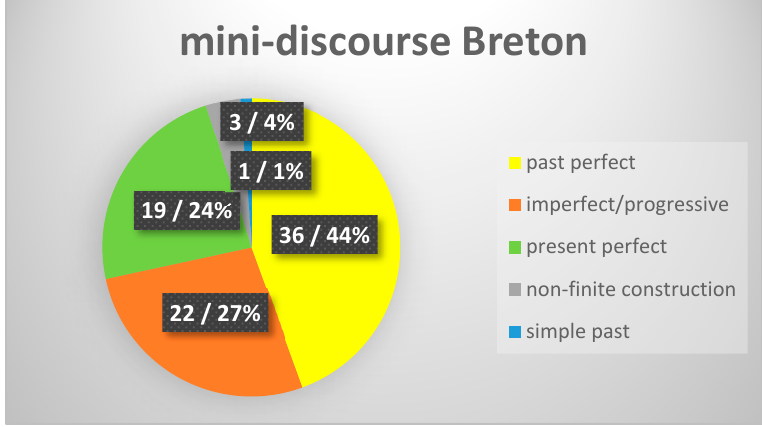
Figure 6. Distribution of Breton past forms in corpus C (mini-discourse).